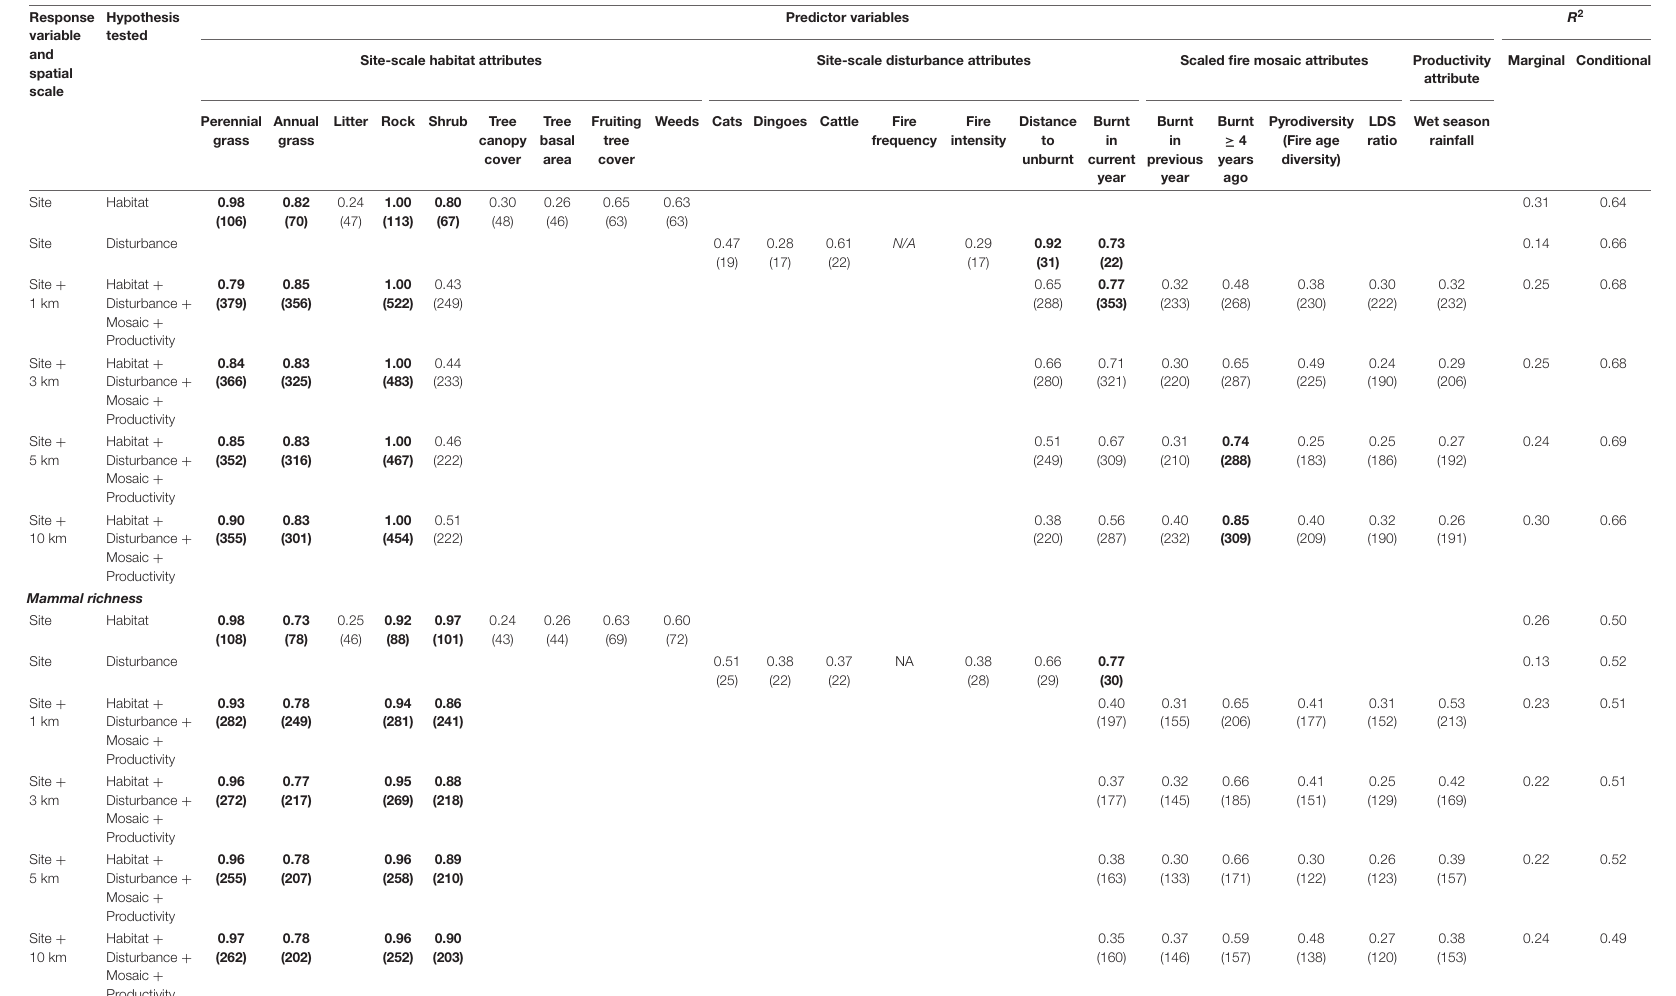
Relative variable importance values (w + ) and the number of models containing the variable (N, in brackets) derived from the 95% confidence model set generated from model-averaging are shown. Highly influential variables (w + ≥ 0.73) are indicated in